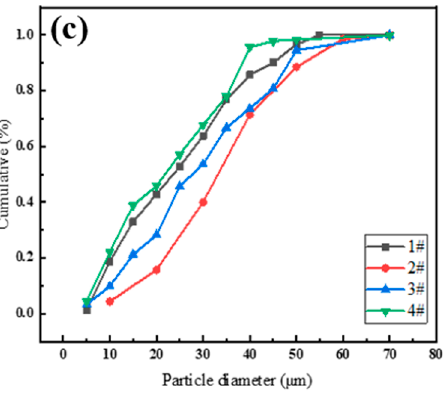
Figure 4. SEM overall morphology of high entropy alloy powder surface and local magnification of ( a1, a2 ) 1# and ( b1, b2 ) 2# Powders. ( c ) Relationship between cumulative mass distribution and size of four high entropy alloy powders.